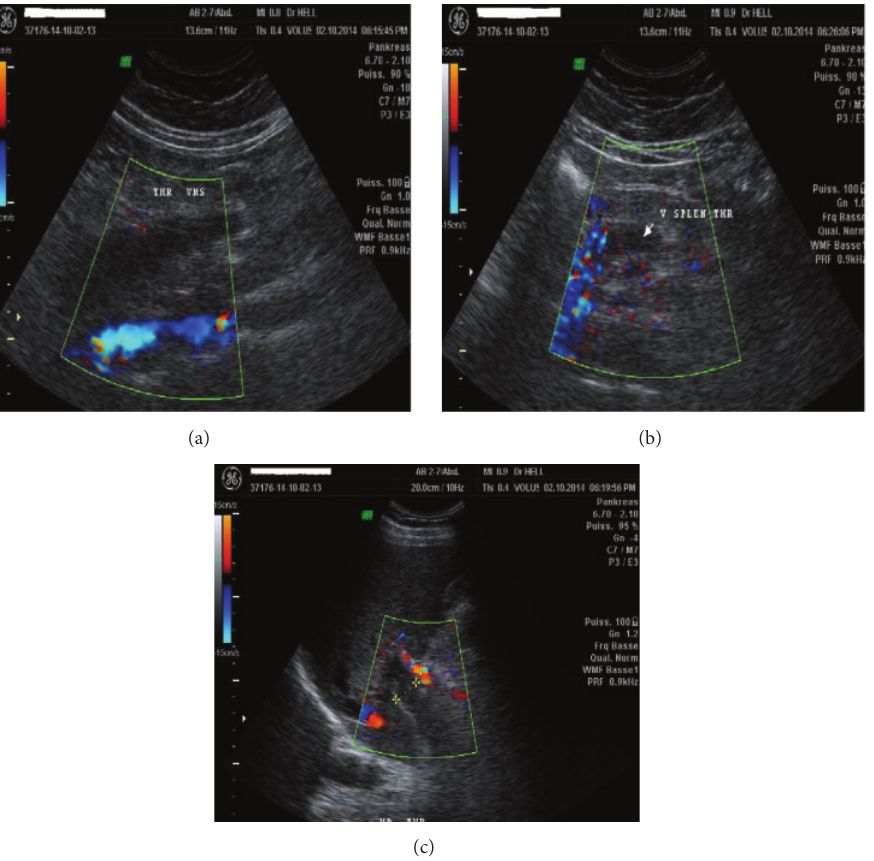
Figure 1: Doppler ultrasonography: showing in (a) the superior mesenteric vein thrombosis, in (b) the splenic vein thrombosis, and in (c) the portal vein thrombosis. With the permission of Medical Imaging Centre (MIC) in